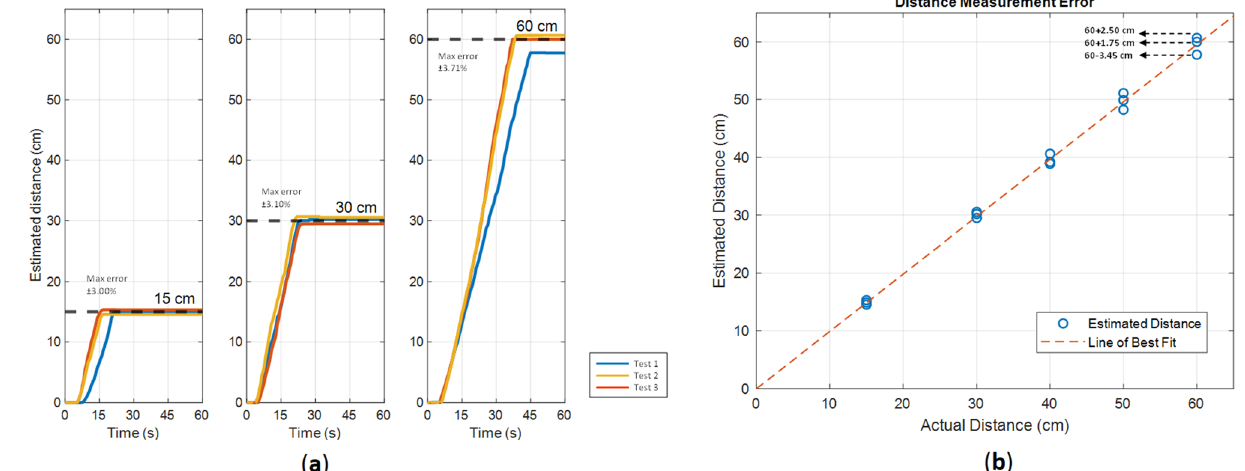
Figure 10. ( a ) Repeat the same path ( b ) Distance measurement error.